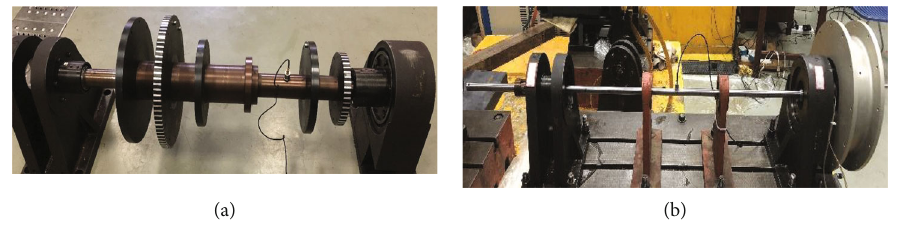
Figure 6: Natural frequency tester: (a) gas-generator rotor tester; (b) power-turbine rotor tester.